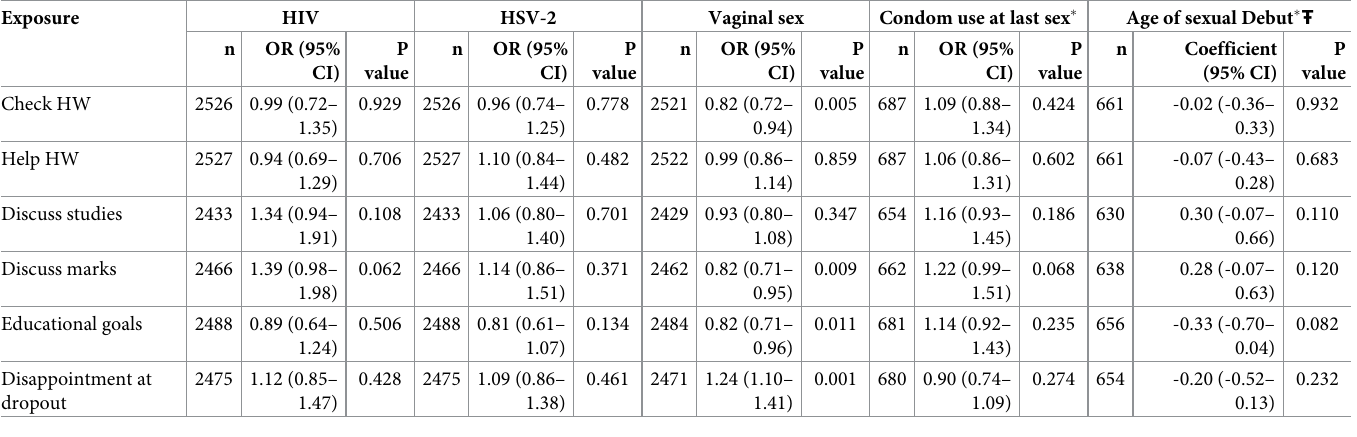
Table 5. Associations between household educational support and HIV, HSV-2 and Sexual risk behaviours, adjusted for age and grade at enrollment.